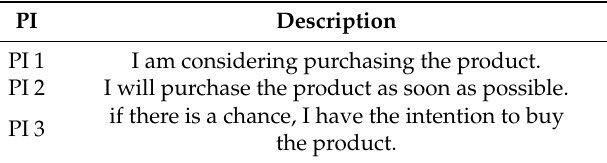
Table 1. Items used in the purchase intention (PI) scale.